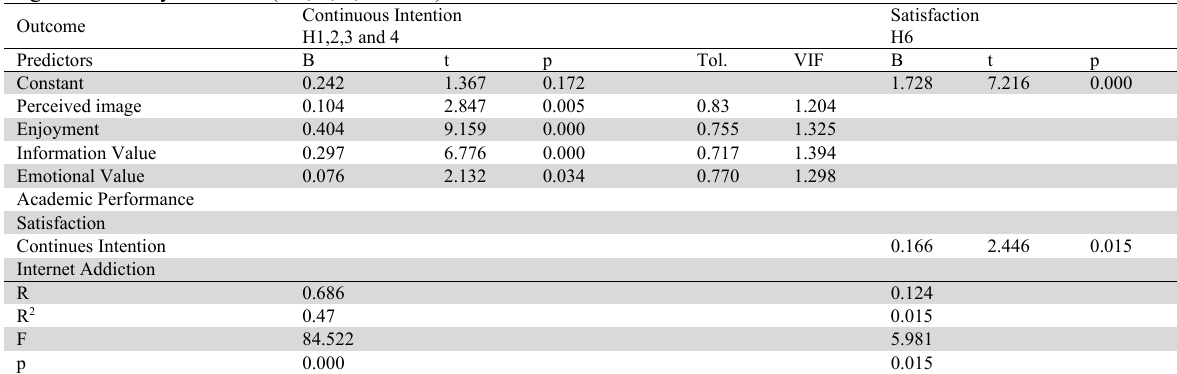
Regression Analysis results (H1, 2, 3, 4 and 6)